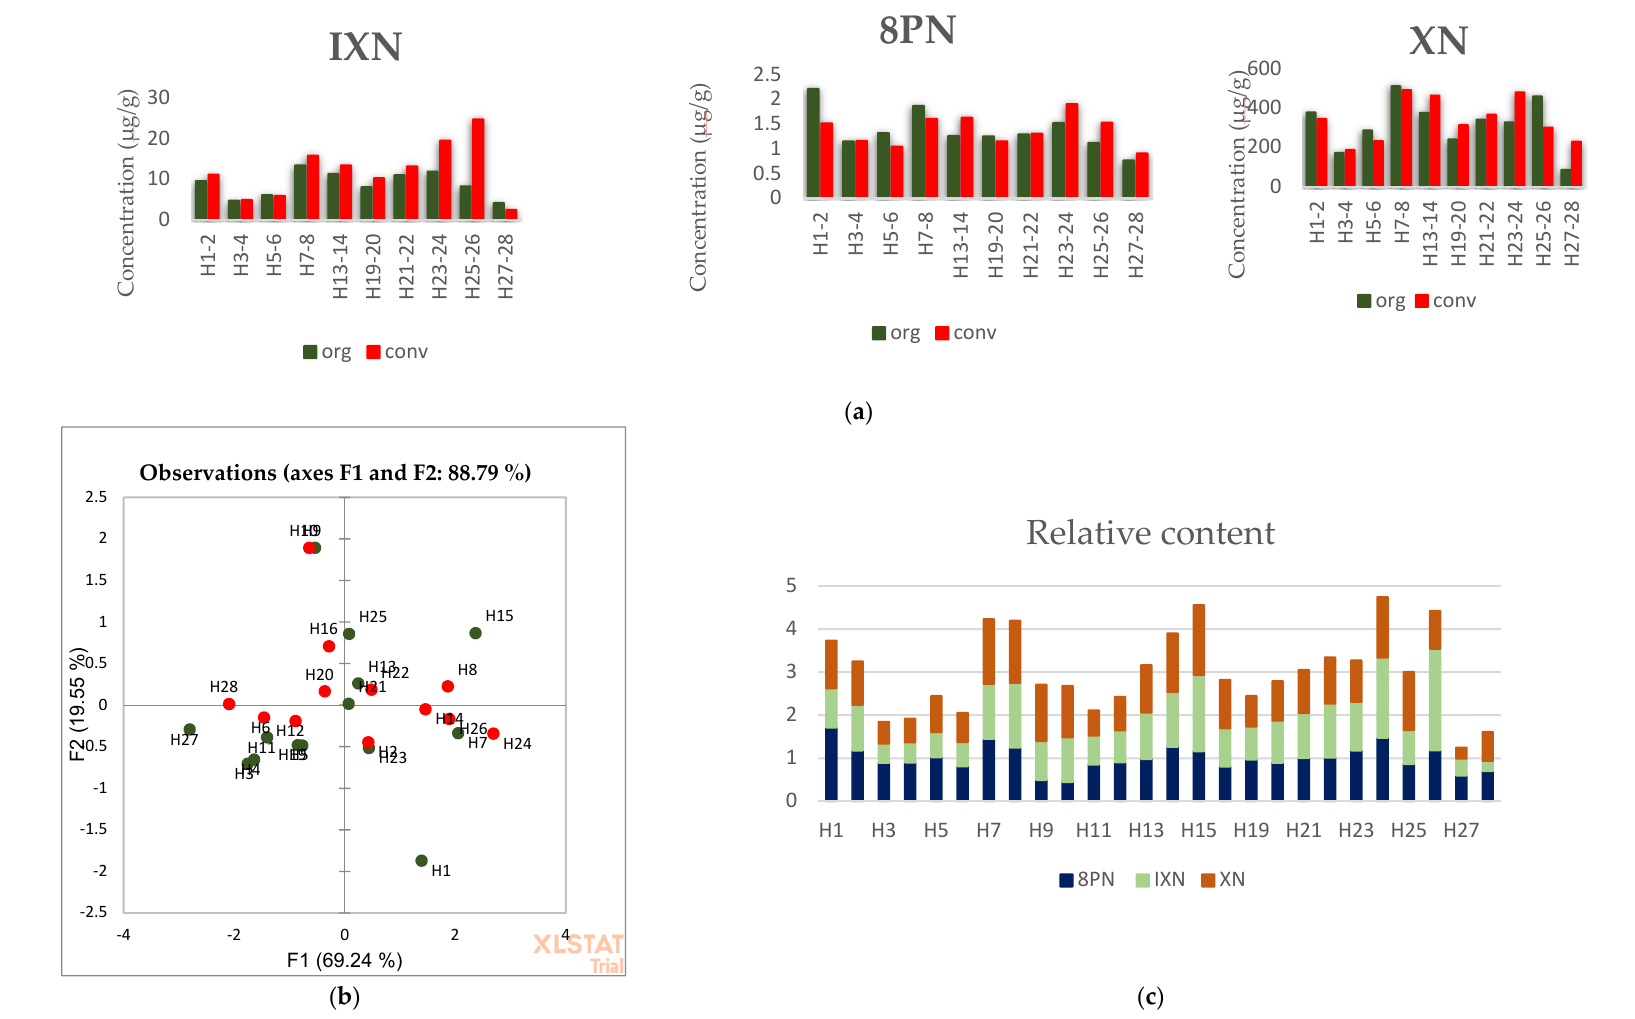
Figure 2. Histograms showing a comparison of the analyte content in the matched pairs of hops ( a ); PCA graph of hops samples with analyte content as variables ( b ); Histogram of total contents of the analytes in hops samples expressed as the sum of relative contents to the average level of a single analyte in the whole group ( c ).